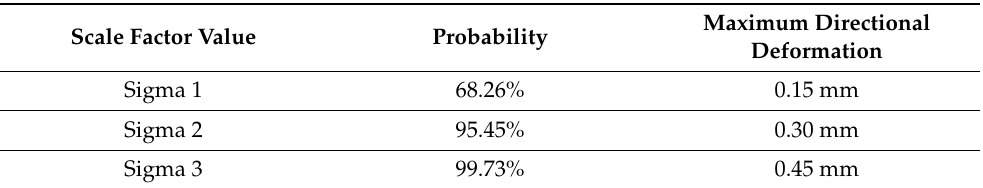
Table 4. Scale factor values, probability of occurrence, and maximum directional deformation result for random vibration analysis.